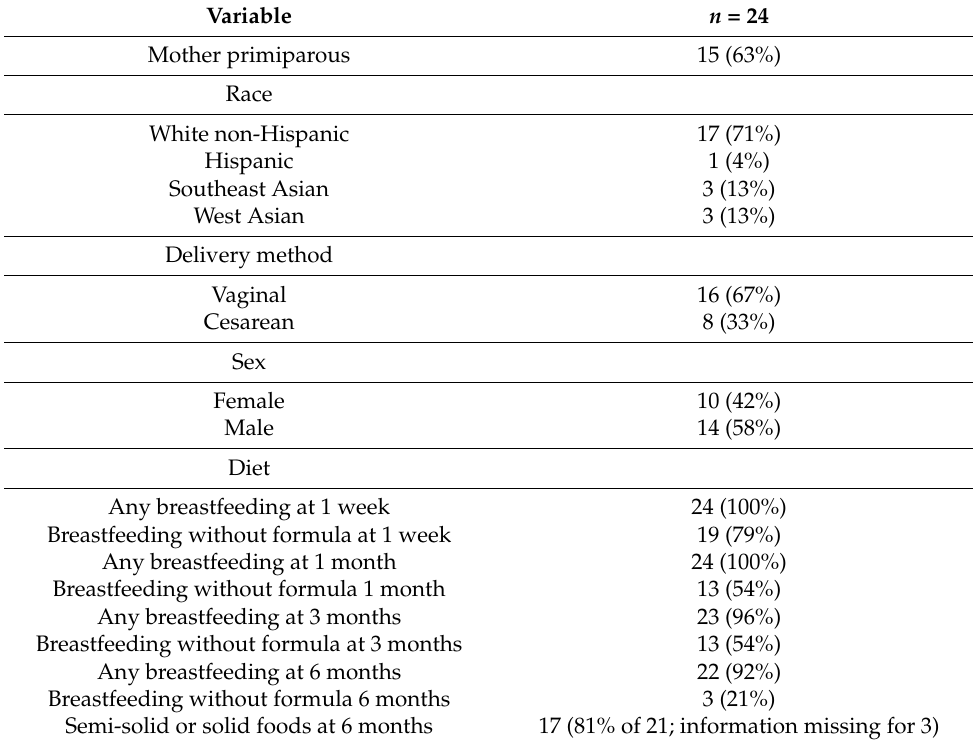
Table 1. Characteristics of enrolled